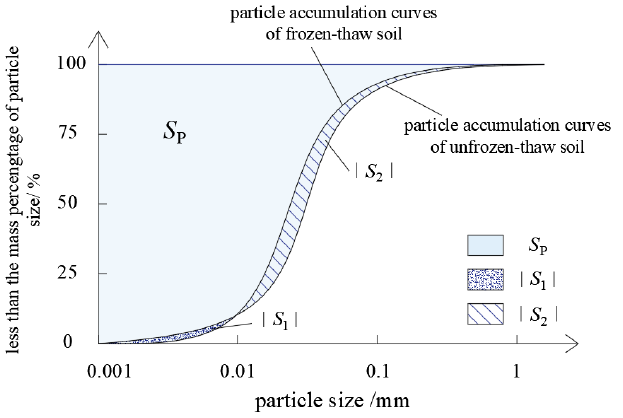
Figure 9. Schematic diagram of total particle size variation index.